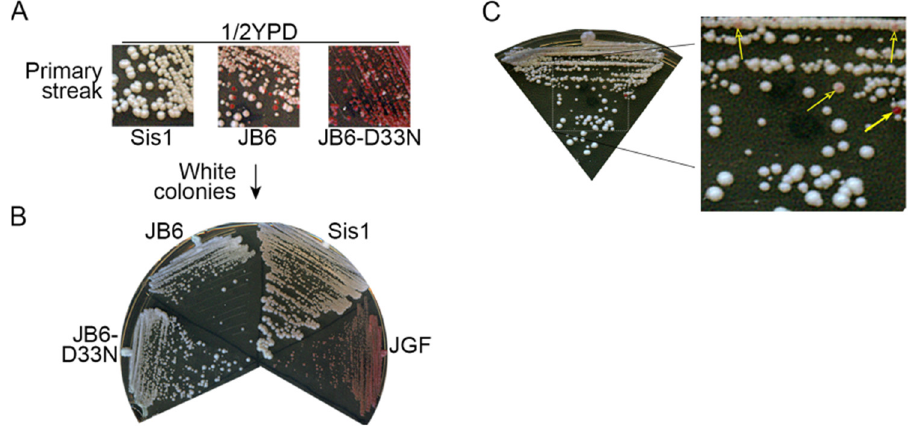
Figure 2. DnaJB6b impairs [ PSI + ] S propagation weakly. ( A ) Cells recovered from FOA plates of the plasmid shuffle in Figure 1D were streaked onto 1/2YPD medium to monitor prion status—red cells are [ psi − ]. Cells expressing DnaJB6b (JB6) or DnaJB6b-D33N (JB6-D33N) are mixtures of red and white colonies. ( B ) Cells from white colonies in panel ( A ) produce only white colonies when re-streaked. Cells lacking prions and expressing Sis1JGF in place of Sis1 are shown as [ psi − ] control. ( C ) Continued expression of DnaJB6b in cells with Sis1JGF in place of Sis1 lose prions at low frequency, producing rare red colonies (filled arrow, [ psi − ]) and pink colonies (open arrows, mixtures of red [ psi − ] and white [ PSI + ] S give pink